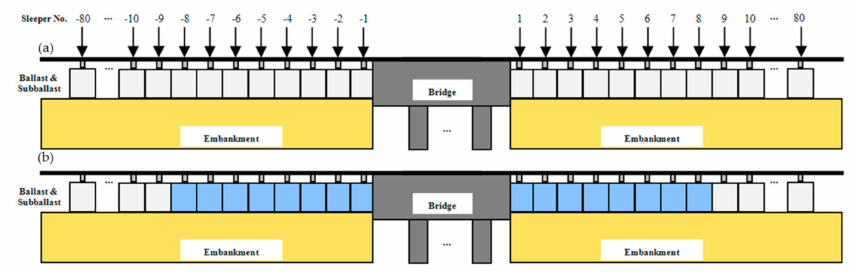
Figure 13. Simulation of the transition zone with high moisture: ( a ) the reference case; ( b ) the high moisture case.